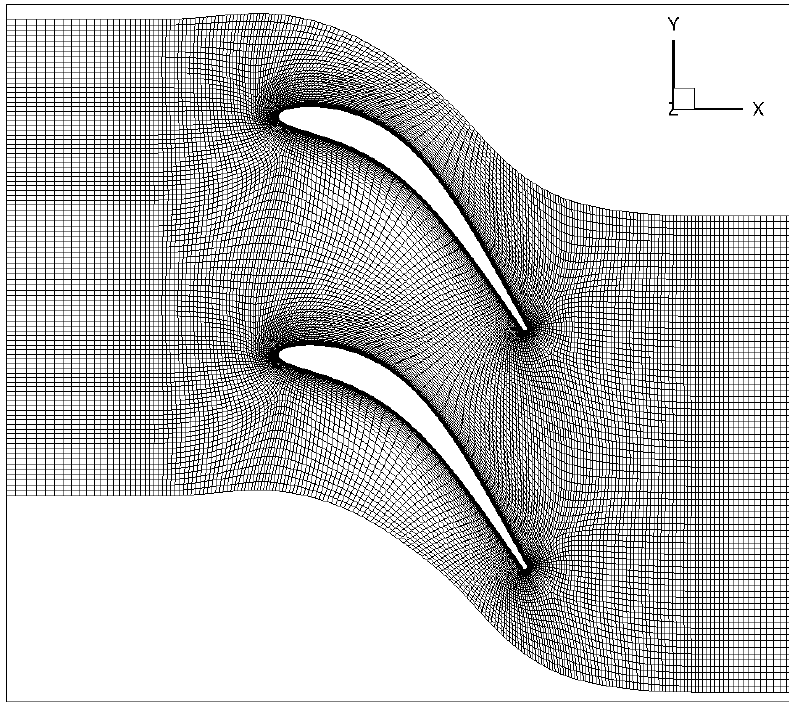
Figure 22. Eleventh standard configuration computational grid.